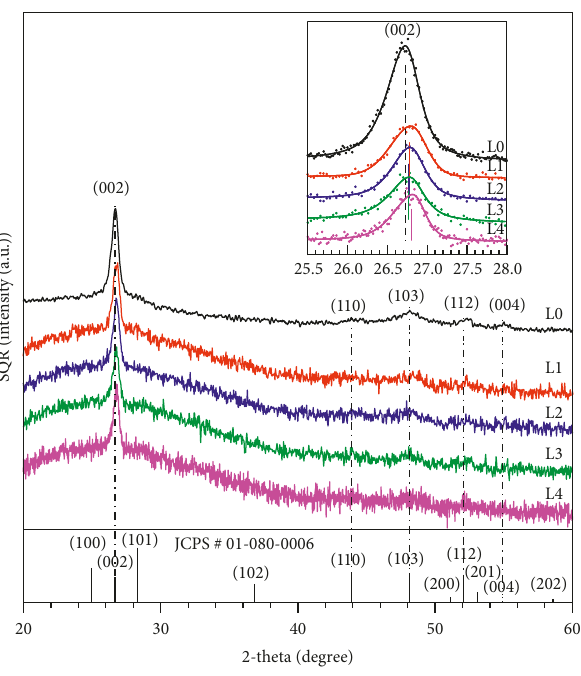
Figure 1: XRD patterns set for CdS:Cu films obtained by ionic exchange process in aqueous solution. The inset in the upper-right zone is an enlargement around the (002) reflection.